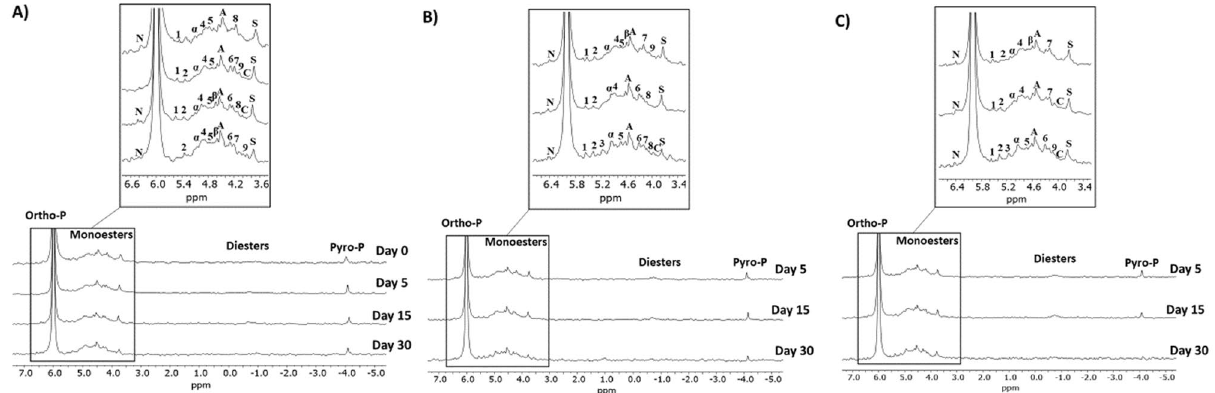
Figure 4. 31 P solution-state NMR spectra of soil extracts from the ( A ) control, ( B ) nitrate (3.5 mg N kg −1 ), and ( C ) ammonium (3.5 mg N kg −1 ), on days 5, 15, and 30 of the incubation as well as day 0 of the A) control. Soils were extracted with NaOH-EDTA. Peaks assigned as Ortho-P: orthophosphate, N: neo-IHP, α: α-glycerophosphate, β: β-glycerophosphate, A: adenosine 5 ′ monophosphate, C: choline phosphate, S: scyllo-IHP, and Pyro-P: pyrophosphate. Unknown monoester peaks are denoted by 1, 2, 3, 4, 5, 6, 7, 8, and 9. The region from ~ 5.8–3.4 ppm includes orthophosphate monoesters as well as degradation products of orthophosphate diesters, which are also found in the − 0.25 to − 0.75 ppm region.